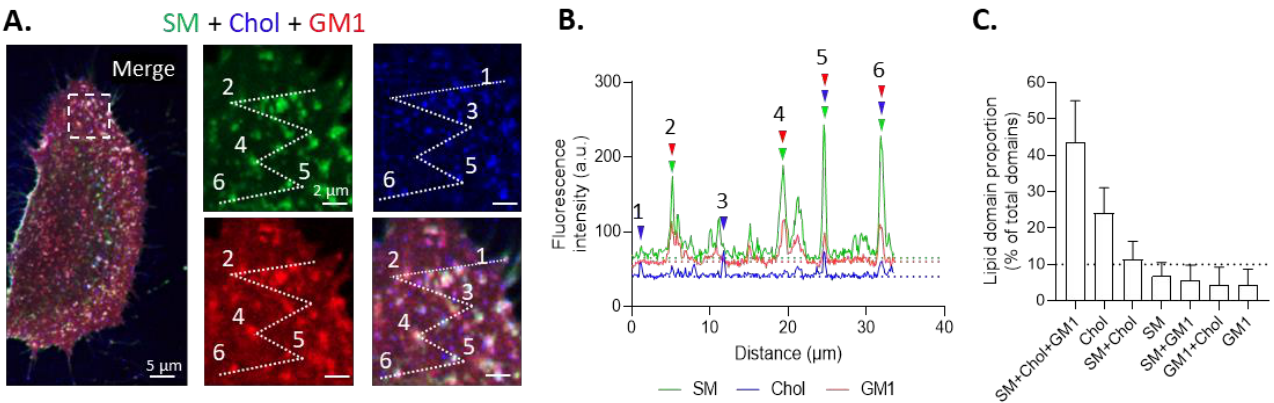
Figure 2. Two main types of domains, enriched in sphingomyelin/cholesterol/GM1 ganglioside vs. cholesterol, mainly coexist at the outer plasma membrane of C2C12 myoblasts. ( A , B ) Cells were triple-labeled for SM (BODIPY-SM), chol (theta), and GM1 (CTxB), visualized by confocal microscopy, and analyzed for lipid domains at the periphery basal side by drawing profiles (dotted white line) and generating graphs of the fluorescence intensity vs. the profile distance. The profiles were manually drawn and designed to cross as many lipid domains as possible in the entire cell periphery. Arrowheads are the domains enriched in lipids from corresponding colors. Green, blue, and red dotted lines indicate the threshold for each fluorescent channel. ( C ) The quantification of lipid domain proportion. Dotted line is the threshold for lipid domains acknowledgement. The data are expressed as means ± SD ( n = 60 cells from 11 independent experiments, 10–15 profiles drawn, and 150–200 domains